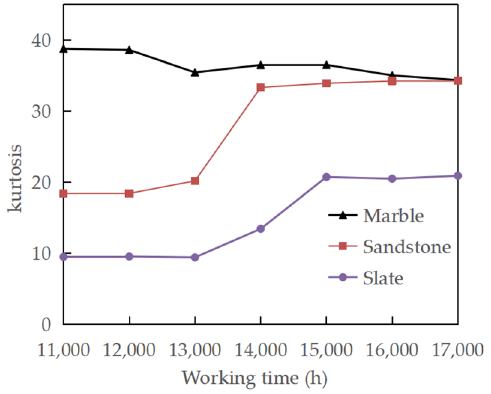
Figure 14. Curve of kurtosis with time.